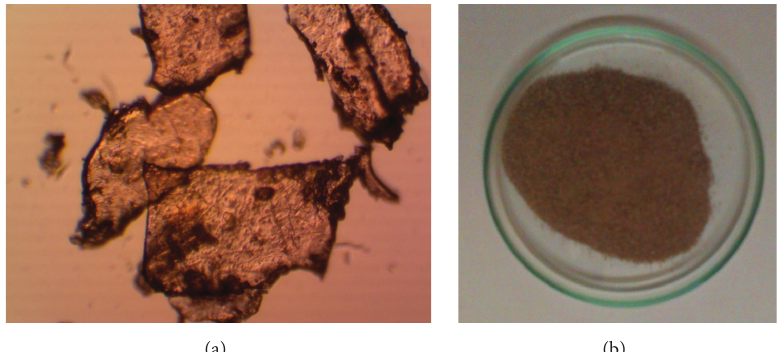
Figure 1: Photograph of gum powder taken (a) under high magnification microscope and (b) using digital camera.